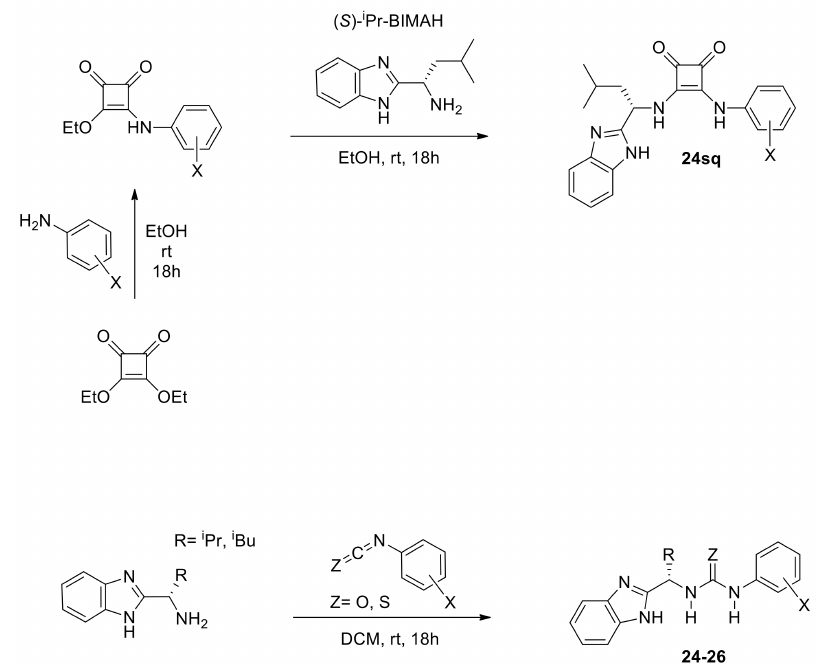
Scheme 8. Types of chiral organocatalysts designed for the asymmetric Pinder reaction bearing a Lewis acid and a nucleophilic/basic domain.